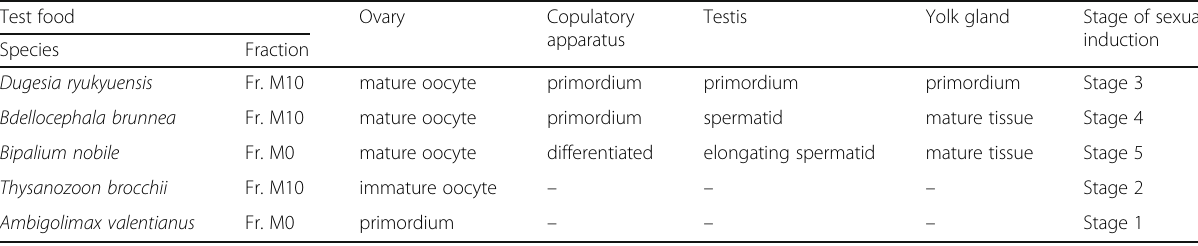
Testis Yolk gland Stage of sexual apparatus induction